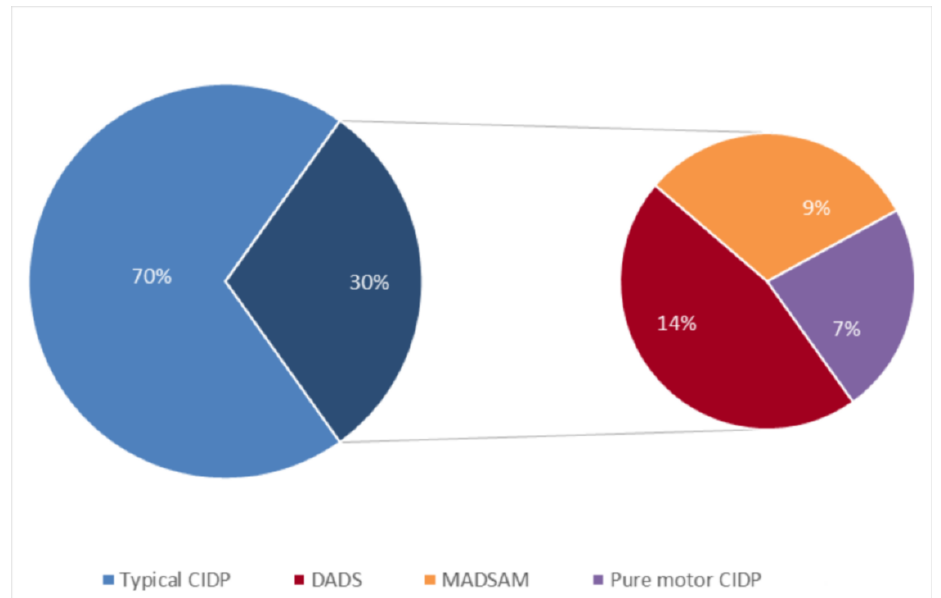
Figure 3. Distribution of clinical phenotypes among CIDP patients that underwent a sural nerve biopsy.